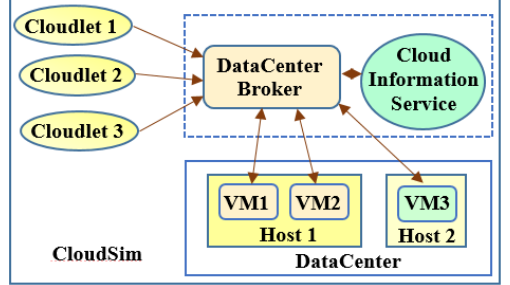
Figure 2 . CloudSim Simulator’s